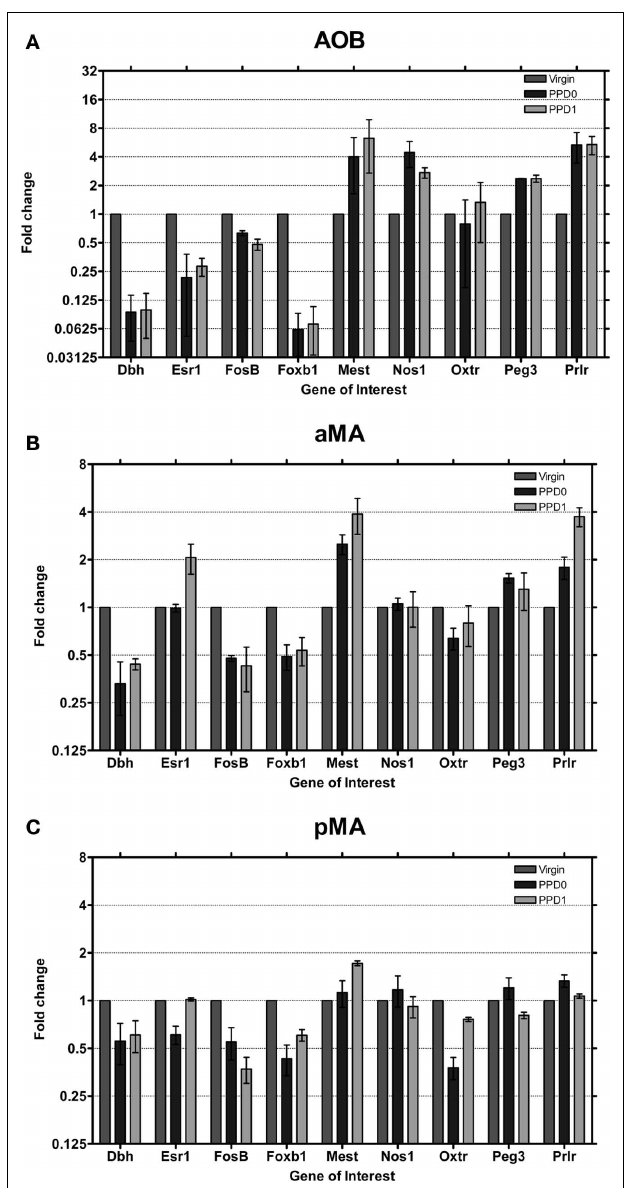
FIGURE 5 | Changes in fold expression (determined by C T method) at PPD0 and PPD1 in the (A)AOB, (B) aMA, and (C) pMA. Mean ± SD are plotted on a log2 scale, such that fold increases and decreases are represented